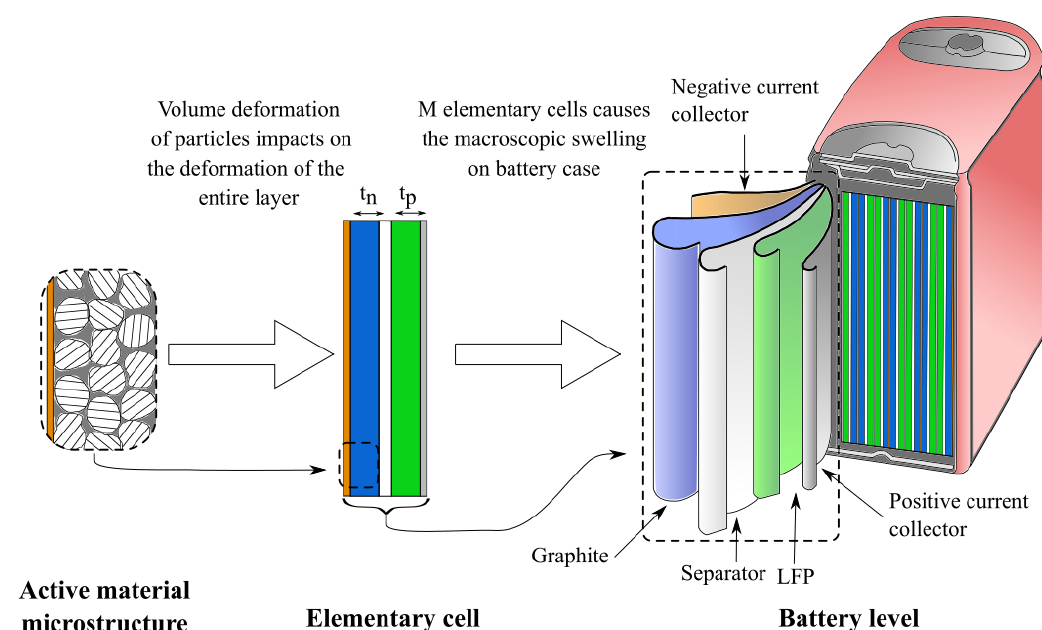
Figure 4. Internal structure of a prismatic LIB. From the micro-structure of active material, through the elementary cell, to cell level. Negative and positive electrode thickness are, respectively, t n and t p .